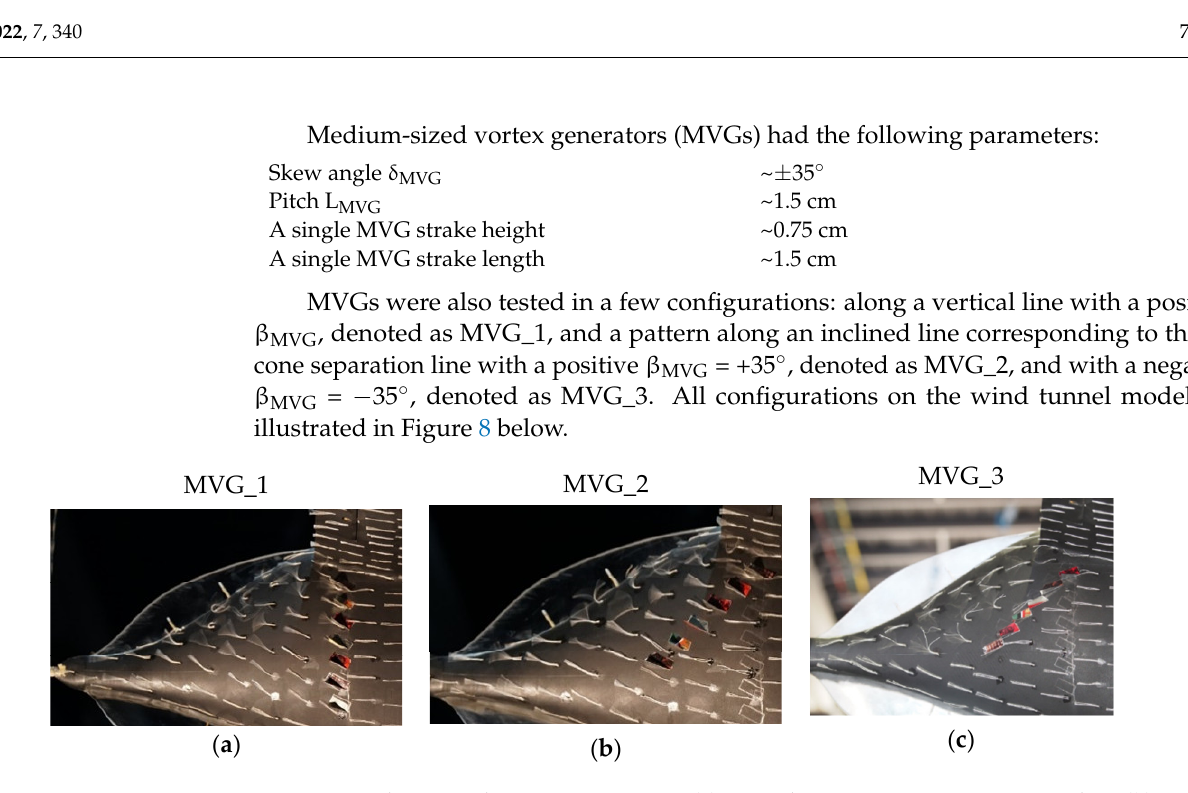
Figure 8. Medium-sized MVG in 3 positions: ( a ) vertical pattern upstream separation line, ( b ) inclined coincident with the separation line, and ( c ) inclined coincident with SL with a negative skew angle.